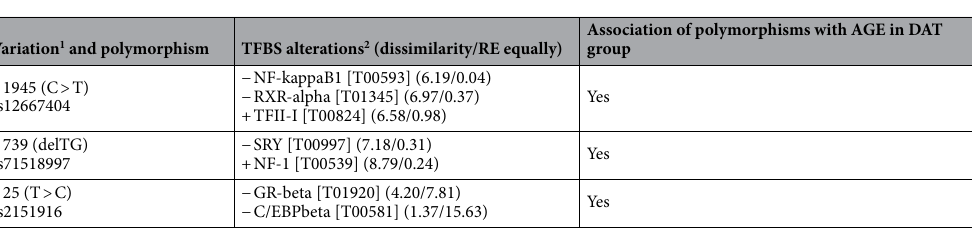
Table 4. Sequence variants in the CD36 5 ′ regulatory region of patients with Alzheimer’s disease. 1 Positions relative to the CD36 Exon 1a TSS [Gen-Bank: DA741325] at position 80,624,092 in NCBI reference sequence NC_000007.14. 2 PROMO analysis using annotations in TRANSFAC version 8.3 entries.